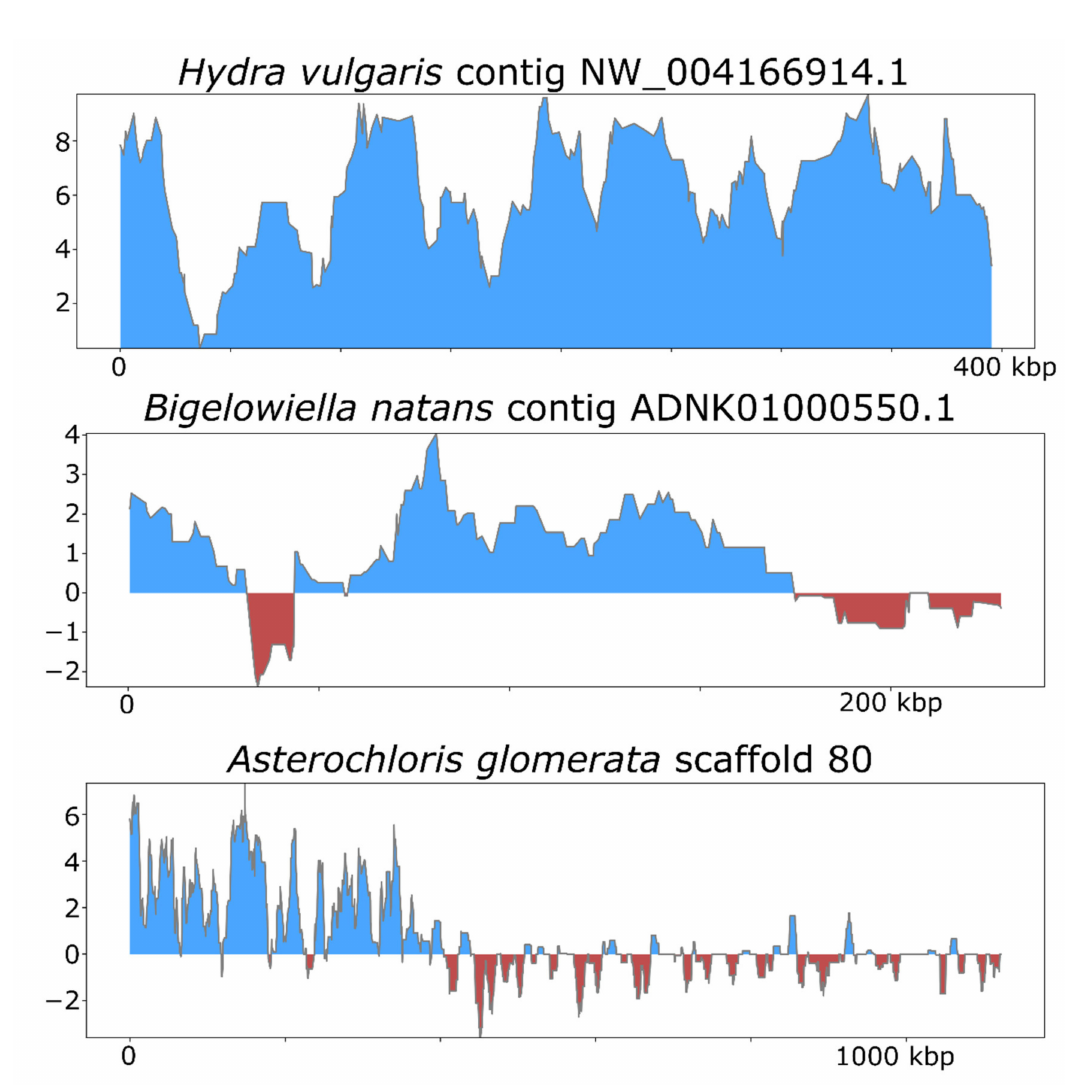
Figure 5. ViralRecall plots for endogenized viral regions identified in Hydra vulgaris , Bigelowiella natans , and Asterochlo- ris glomerata